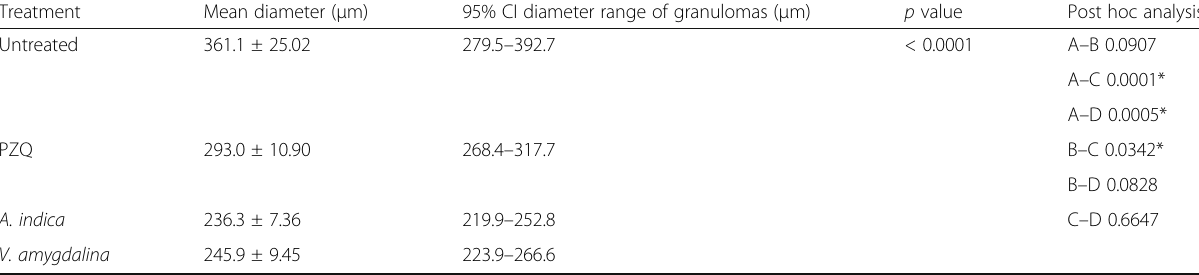
Table 3 Mean diameter of granulomas from liver extract-treated cercariae-infected mice